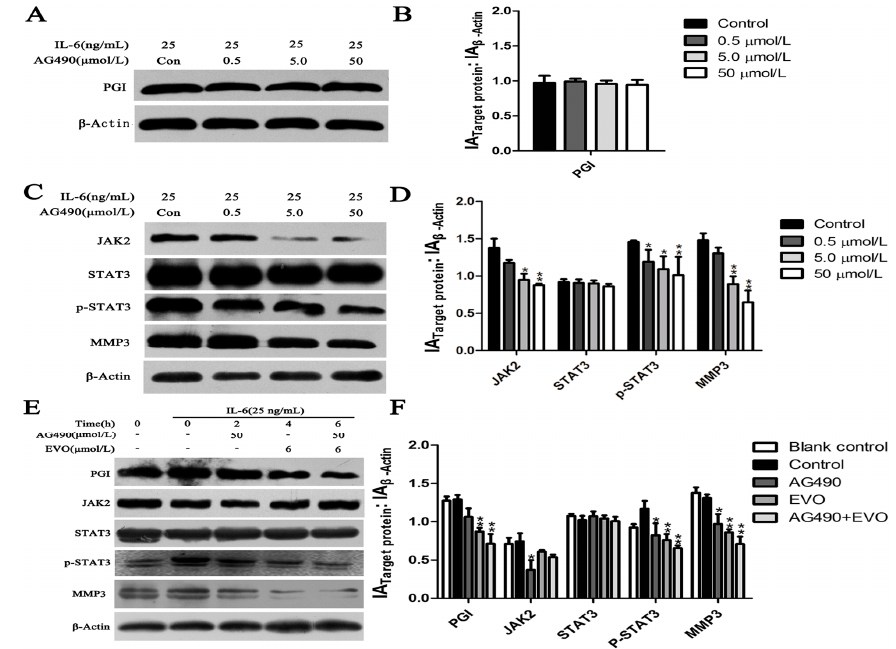
Figure 4. Effects of AG490 and EVO on PGI, the JAK2/STAT3 signaling pathway, and MMP3 in HCT-116 cells. ( A , C ) HCT-116 cells were treated with various concentrations of AG490 for 48 h and then stimulated with 25 ng/mL IL-6 for 15 min, after which whole-cell extracts of PGI, MMP3, JAK2, p-JAK2 (data not shown), STAT3, and p-STAT3 were analyzed by Western blotting; ( E ) HCT-116 cells were treated with 50 μ mol/L AG490, 6 μ mol/L EVO, and combined 50 μ mol/L AG490 with 6 μ mol/L EVO for 6 h, then stimulated with 25 ng/mL IL-6 for 15 min. Protein expression was analyzed by Western blotting; ( B , D , F ) The graph represents densitometry of the results of three independent experiments (mean ± SD). * p < 0.05, ** p < 0.01 compared to the control. The control group of Figure 4A–C with 25 ng/mL IL-6 + 0 µ mol/L AG490, while Figure 4E with 25 ng/mL IL-6 + 0 µ mol/L AG490 + 0 µ mol/L